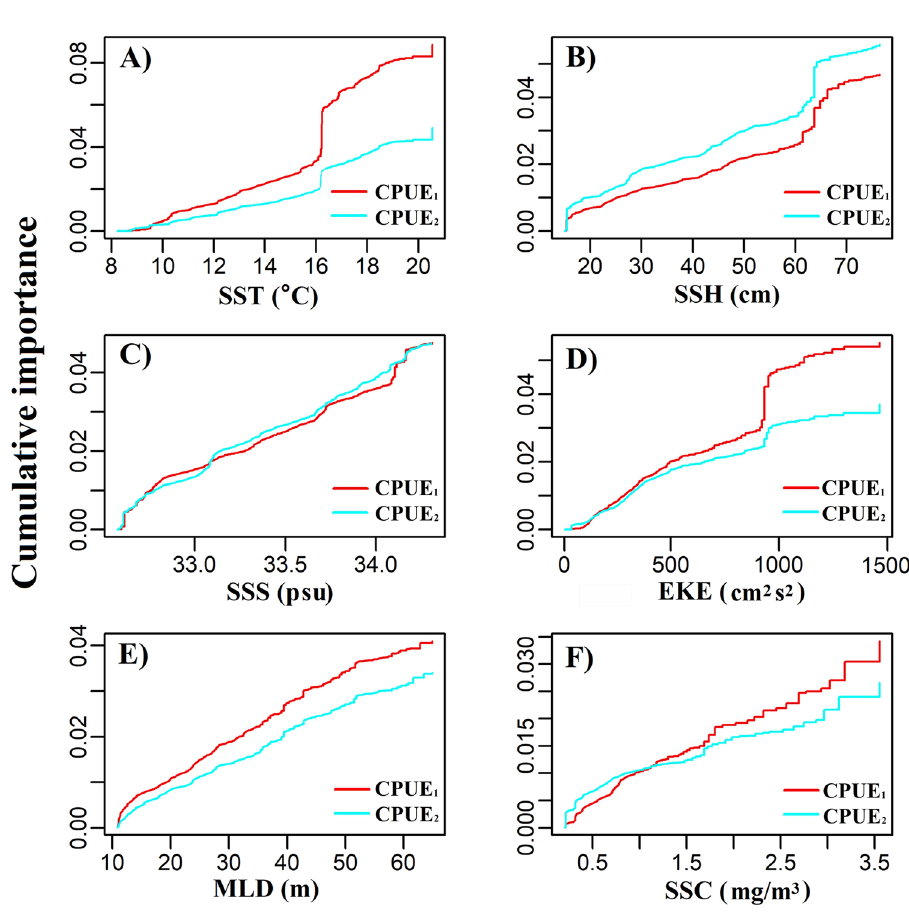
Figure 6. Cumulative shifts (in R 2 units) in CPUE 1 and CPUE 2 in response to environmental variables (SST, SSC, SSS, SSH, MLD, and